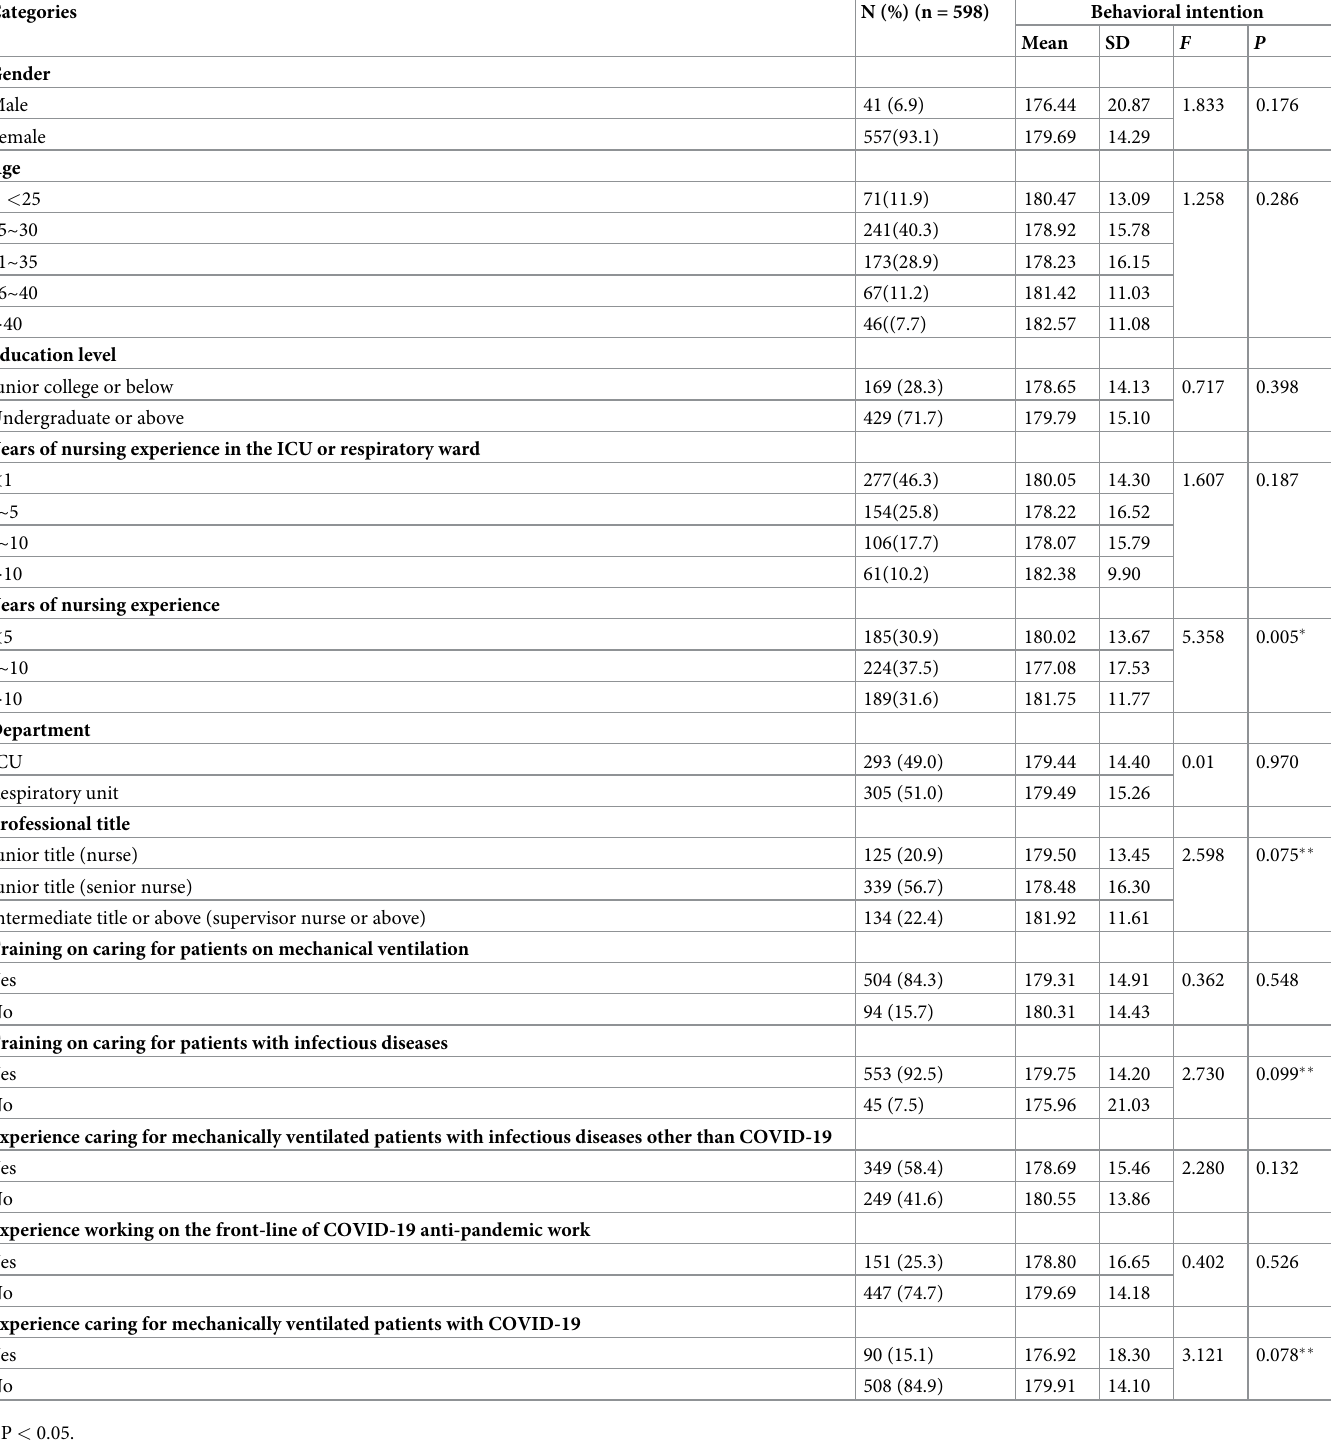
Table 1. Demographic and occupational characteristics of participants and differences in behavioral intention toward caring for COVID-19 patients on mechanical ventilation.